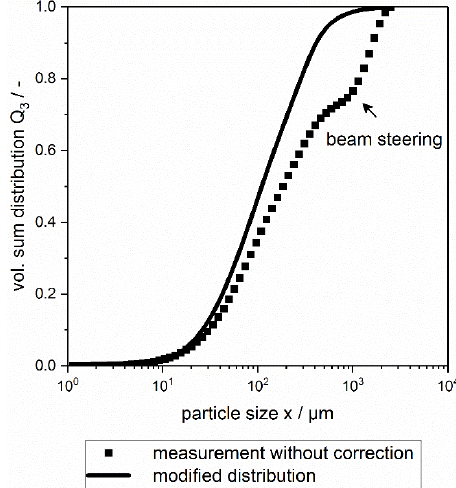
Figure 7. Comparison of uncorrected and modified distributions ( µ = 0.69 Pa · s; p G = 0.8 MPa; 𝑉 ̇ 𝐿 = 20 L/h; GLR = 0.35).